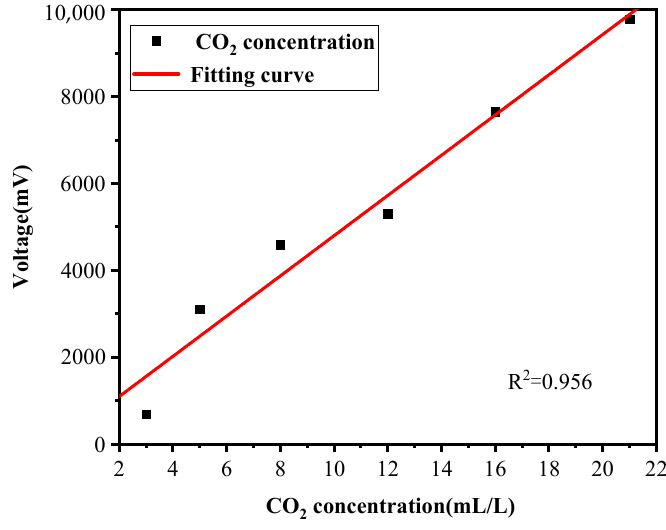
Figure 9. Calibration curves. The second experiment was conducted for the purpose of analyzing how the variation of the laser modulation frequency affects the intensity of photoacoustic signal. We collected 100 sets of data, each of which included 10,240 sampling points obtained by the charge amplifier at each frequency. The peak voltage of each set of data was selected and then the average value calculated. Finally, the curve of the photoacoustic signal intensity under different modulation frequencies was drawn. Figure 10 shows the response of the photoacoustic signal under different modulation